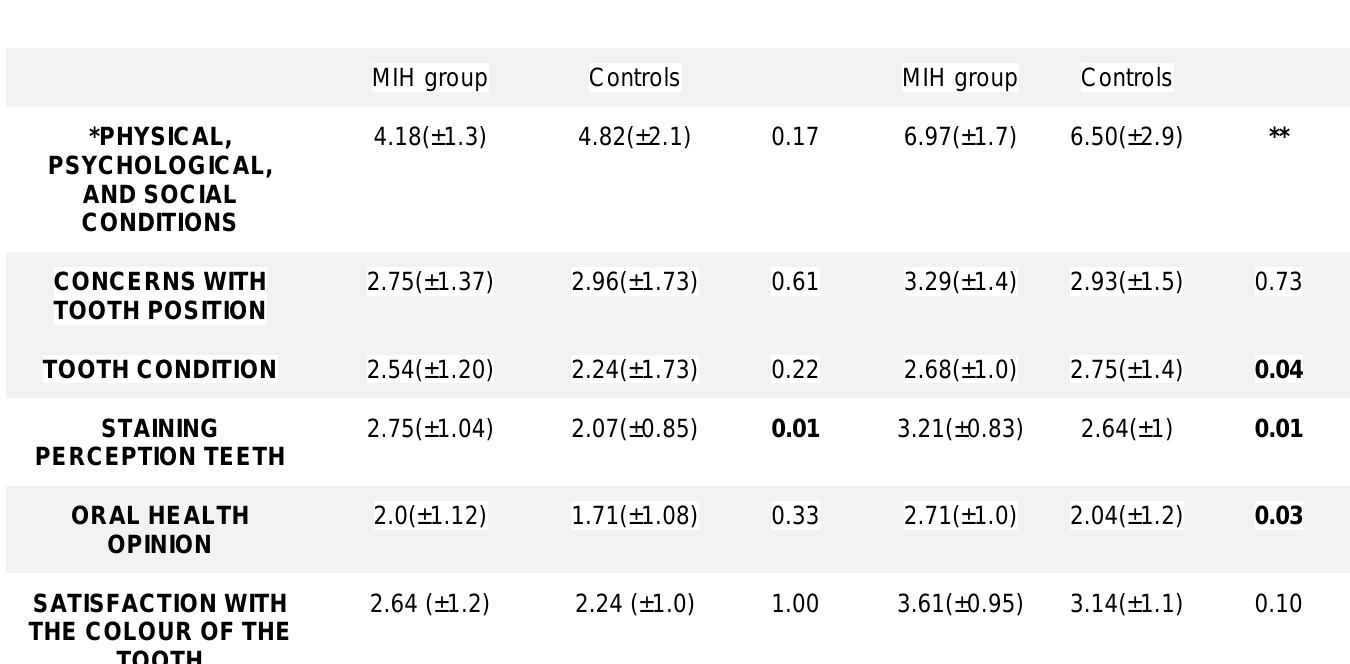
TABLE 2. Evaluation of agreement between parents/children (MIH and controls) for aesthetic perception